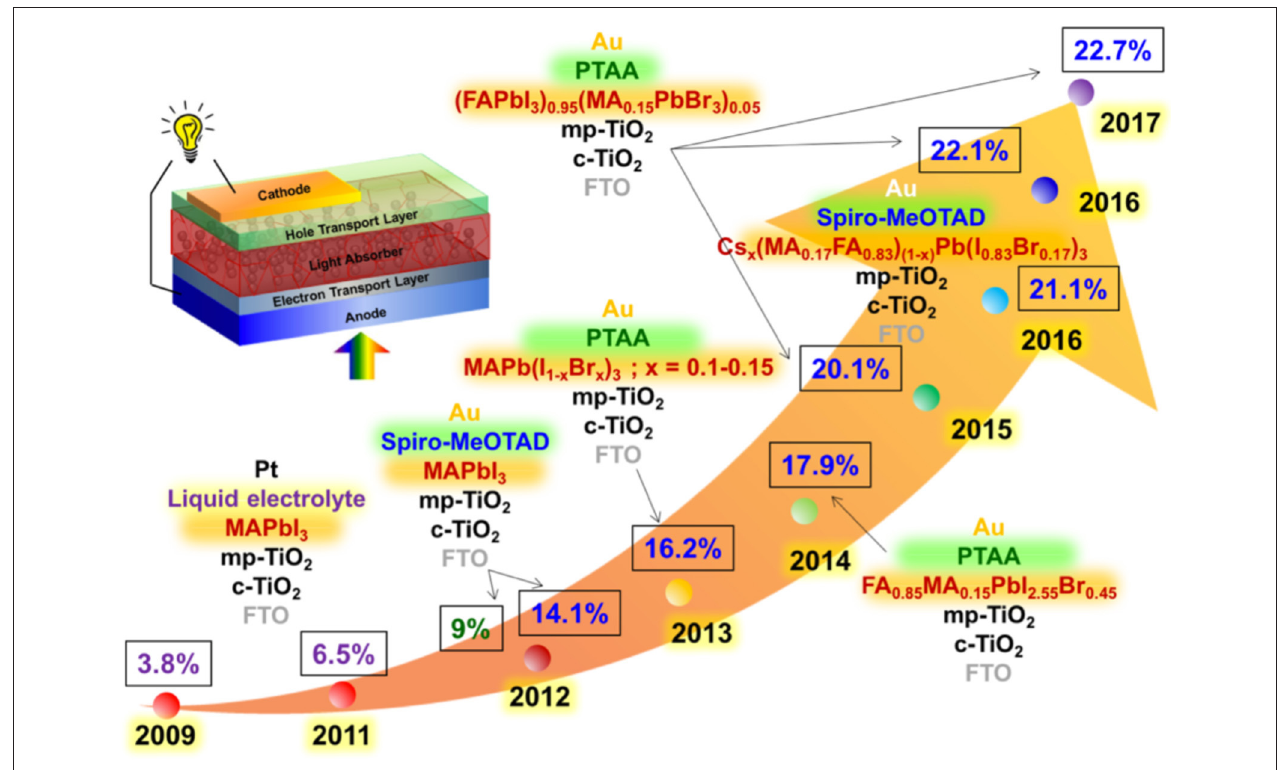
FIGURE 1 | Historical review of PCE with different HTLs and OHPs. Copyright 2018 IOP Publishing. [Reprinted with permission from Ono and Qi (2018)].